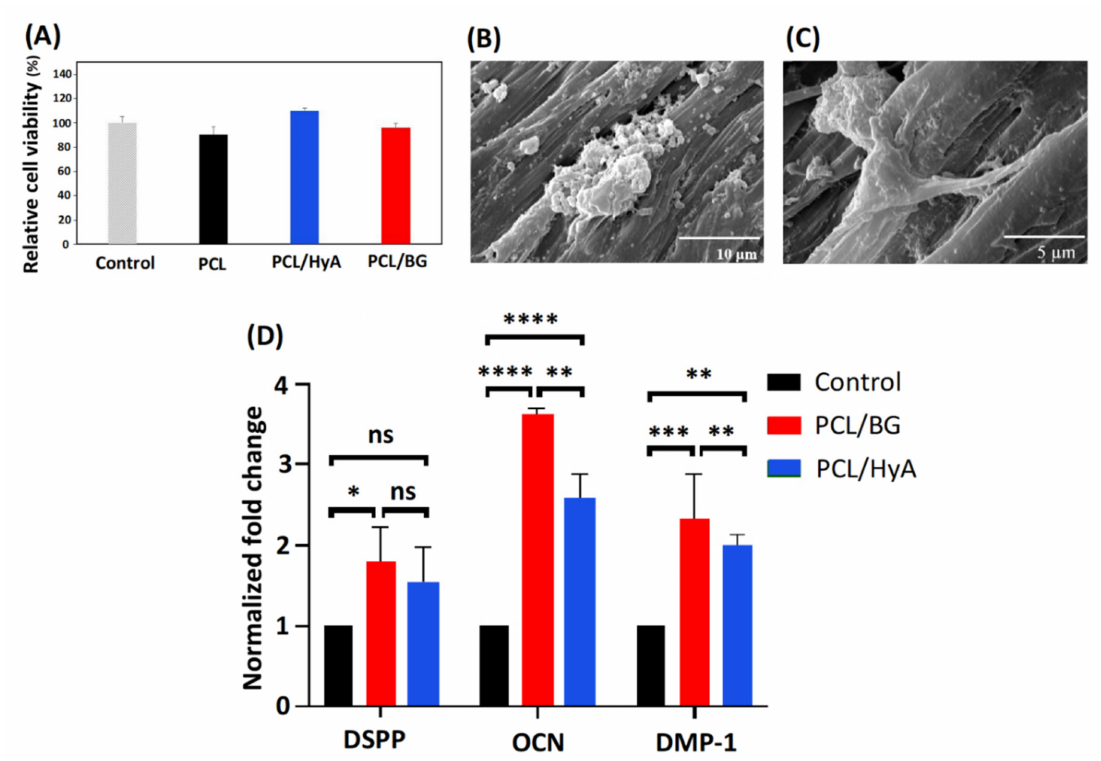
Figure 5. Viability of HGF cells, and morphology and differentiation ability of hDPSCs on 3D-printed scaffolds. ( A ) MTT cell viability analysis; ( B ) hDPSCs attachment on 3D-printed PCL/BG scaffold; ( C ) hDPSCs attachment on 3D-printed PCL/HyA scaffold; ( D ) Gene expression levels of DSPP, OCN, and DMP-1 in hDPSCs cultured in control conditions. ns (not significant), p -value > 0.05; * p -value ≤ 0.05; ** means p -value ≤ 0.01; *** means p -value ≤ 0.001; **** p -value ≤ 0.0001. Abbreviations used in this Figure are as follows: PCL: polycaprolactone, BG: 45S5 bioactive glass, HyA: hyaluronic acid, DSPP: dentin sialophosphoprotein, OCN: osteocalcin, and DMP-1: dentin matrix protein